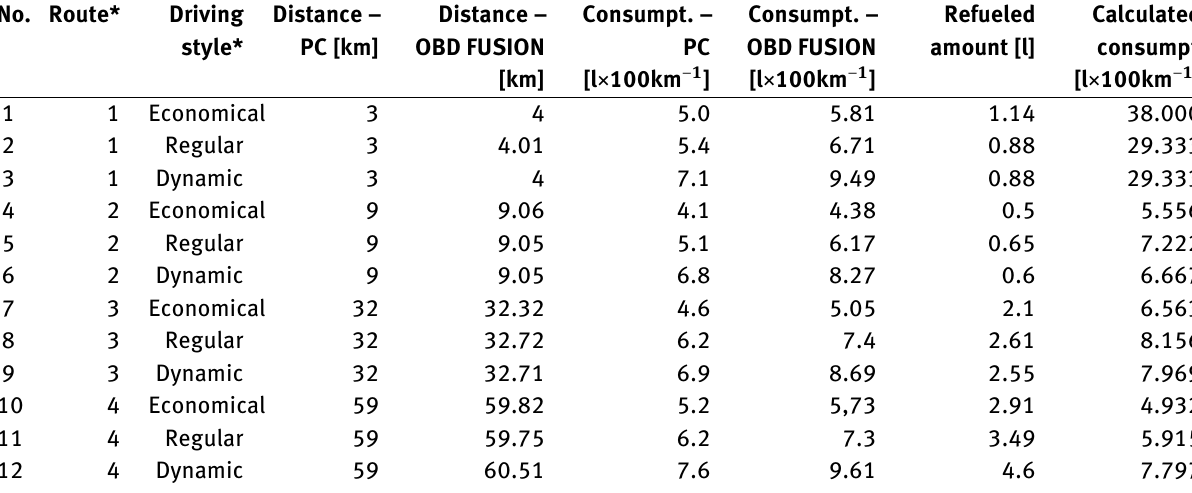
Table 6: Results of the first investigation of fuel consumption related to compression ignition engine No. Route*